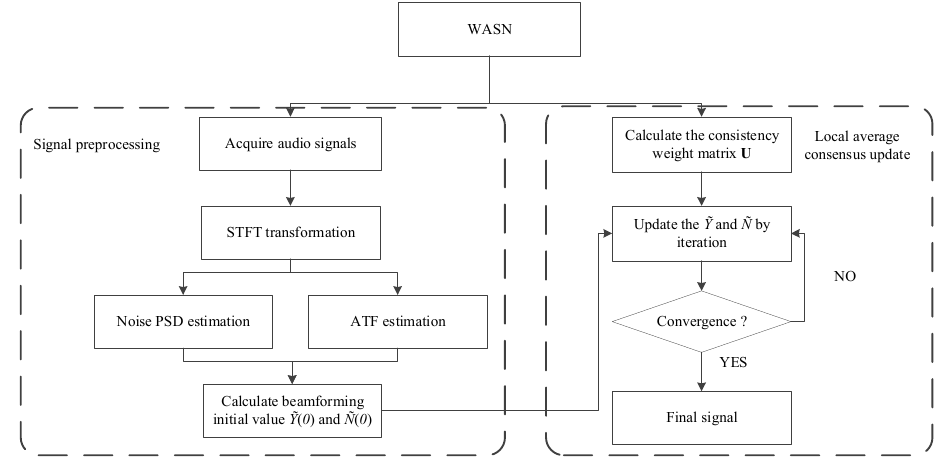
Figure 1. The improved distributed minimum variance distortionless response ( IDMVDR) beamforming method based on the local average consensus algorithm for bird audio enhancement in wireless acoustic sensor networks (WASNs).